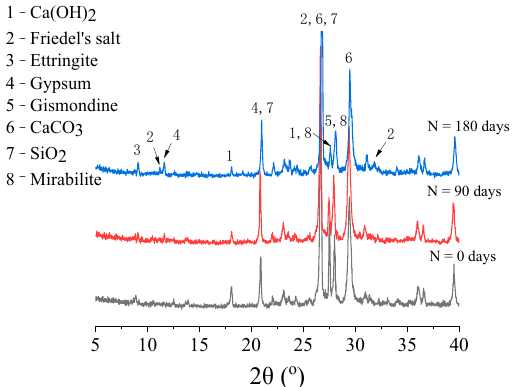
Figure 9. X-ray powder diffraction (XRD) patterns of specimen NC.